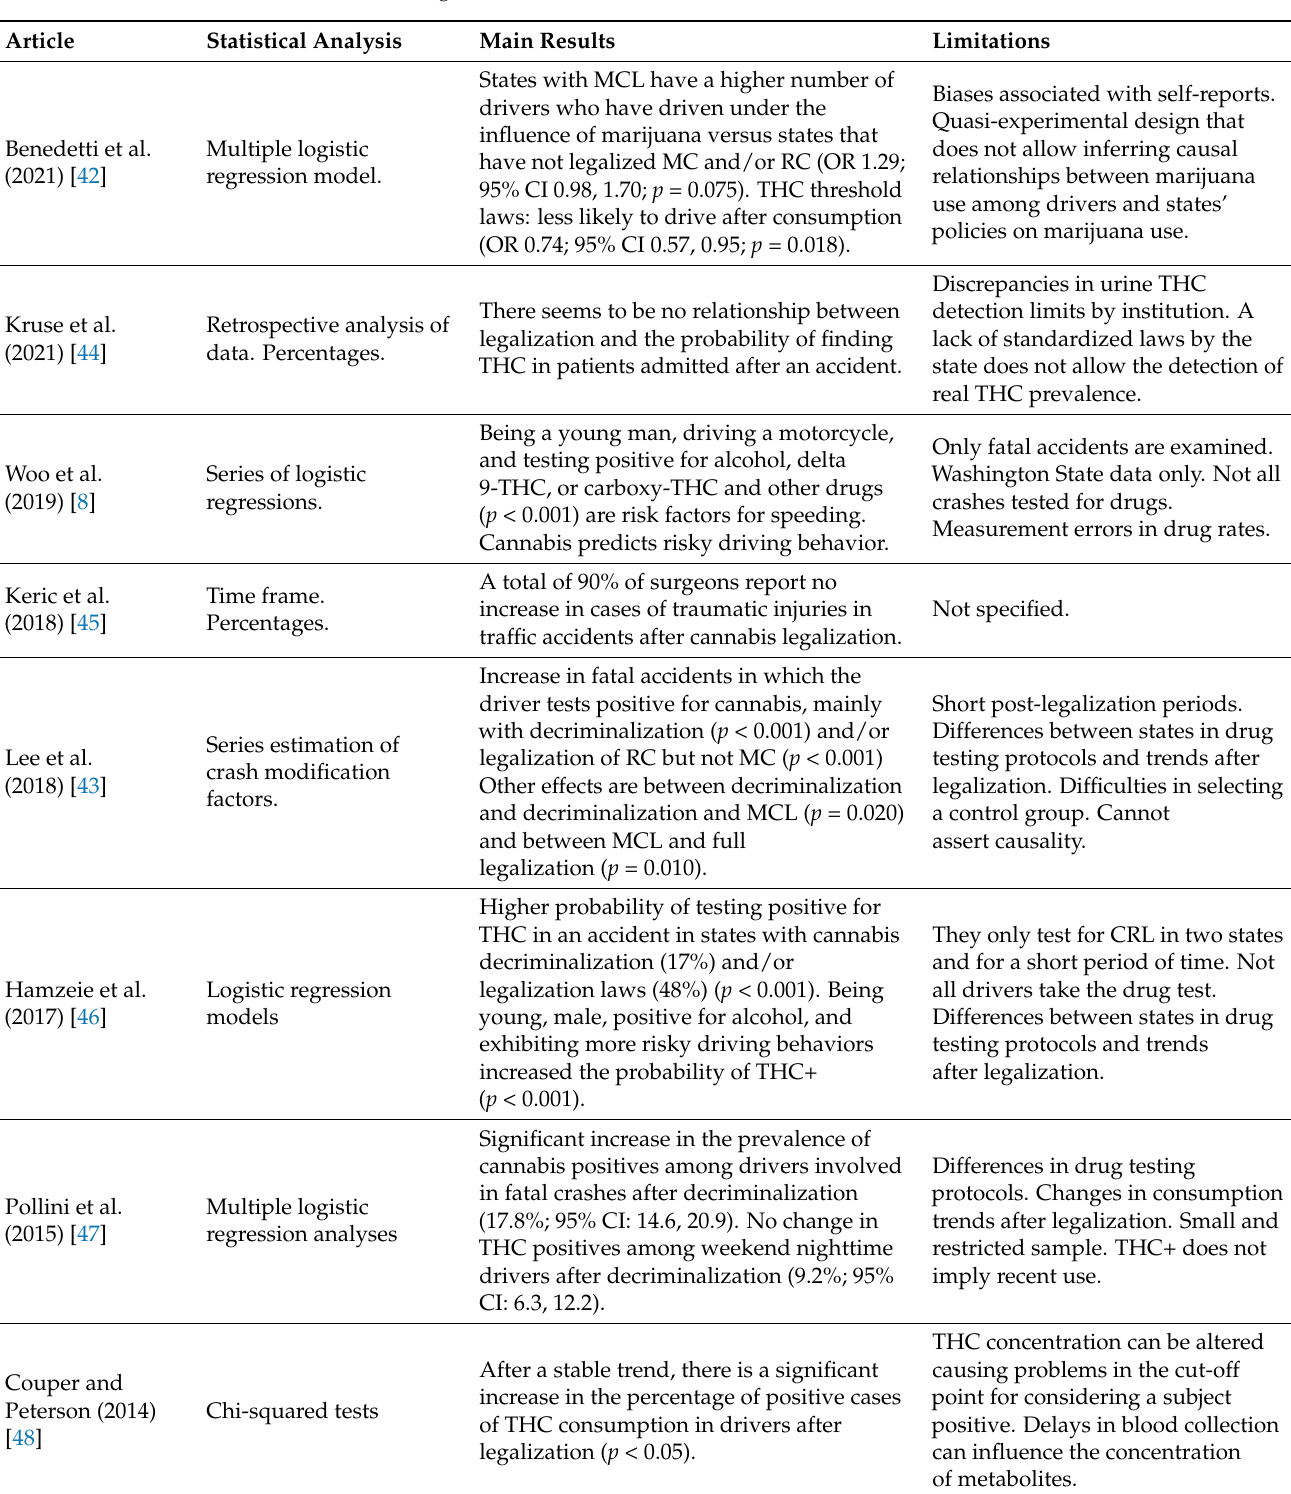
Table 6. Studies related to the legalization of recreational and medicinal cannabis and its decriminal- ization: design, main results, and